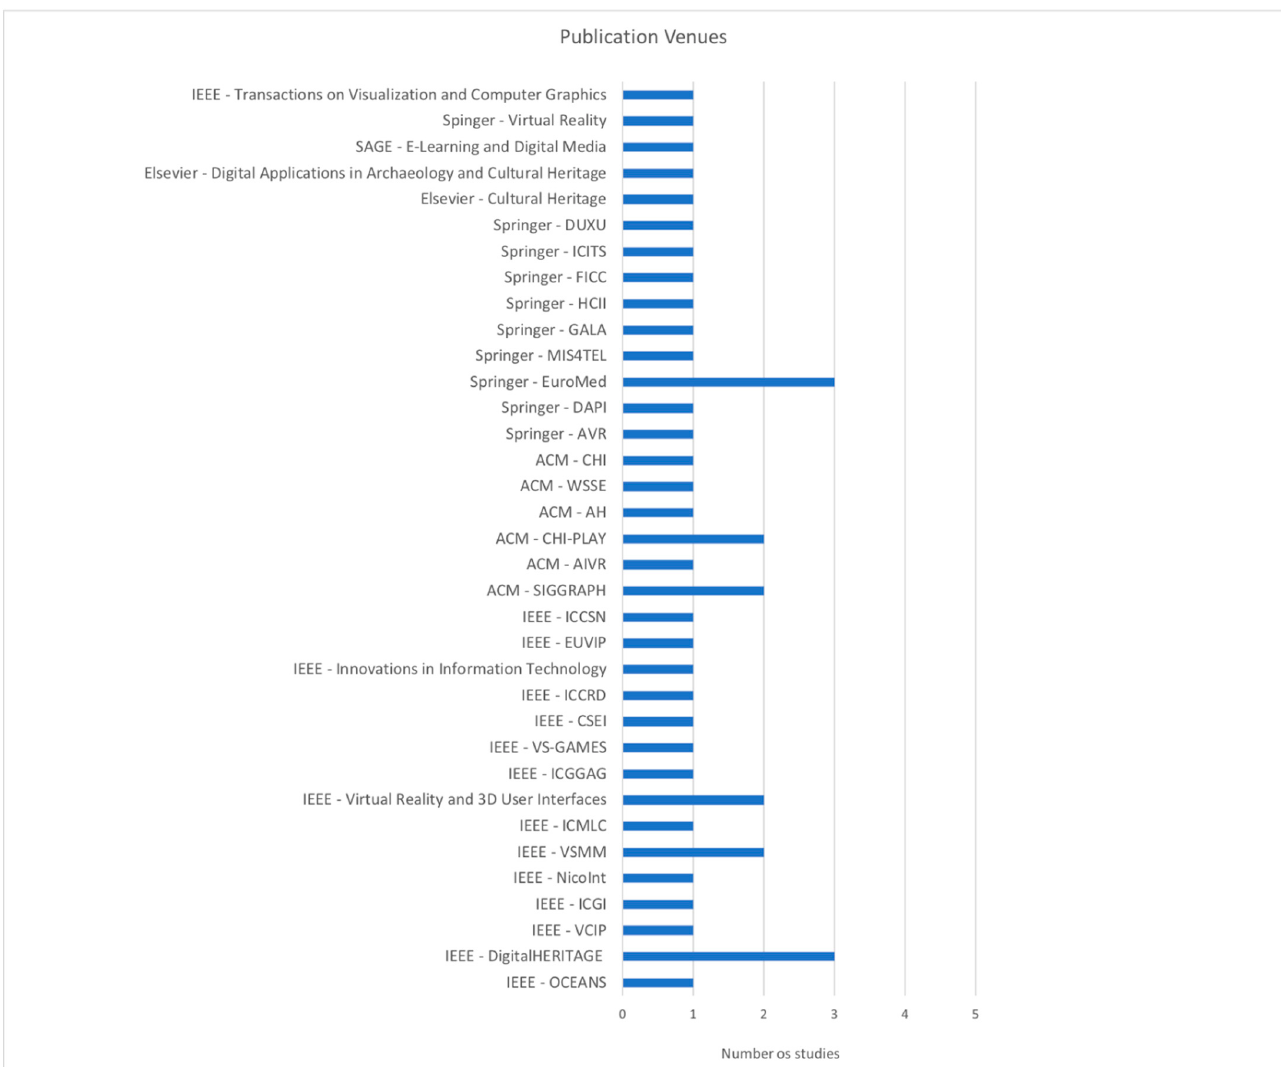
Figure 3. Publication venues of selected works.